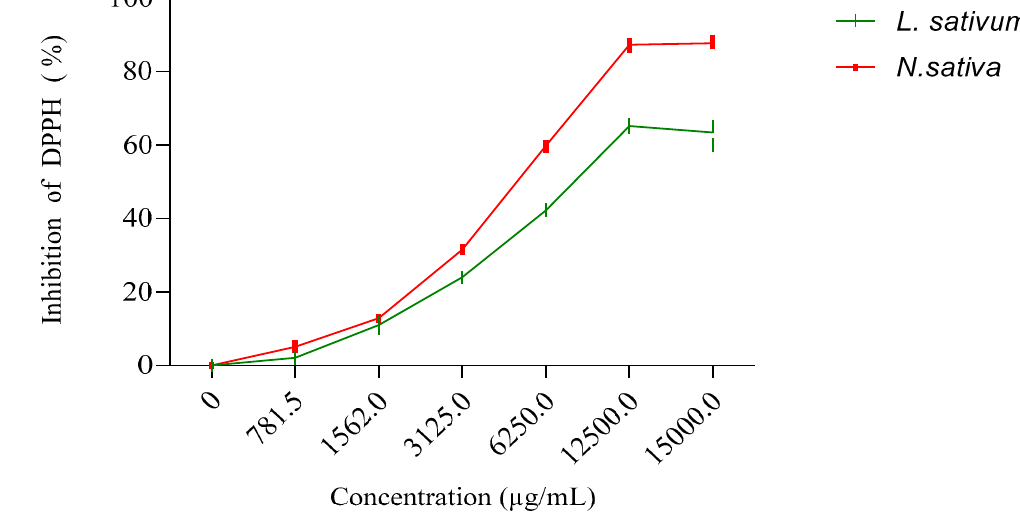
Figure 3. Inhibition of DPPH (%) by fixed oils extracted from seeds of N. sativa and L. sativum .